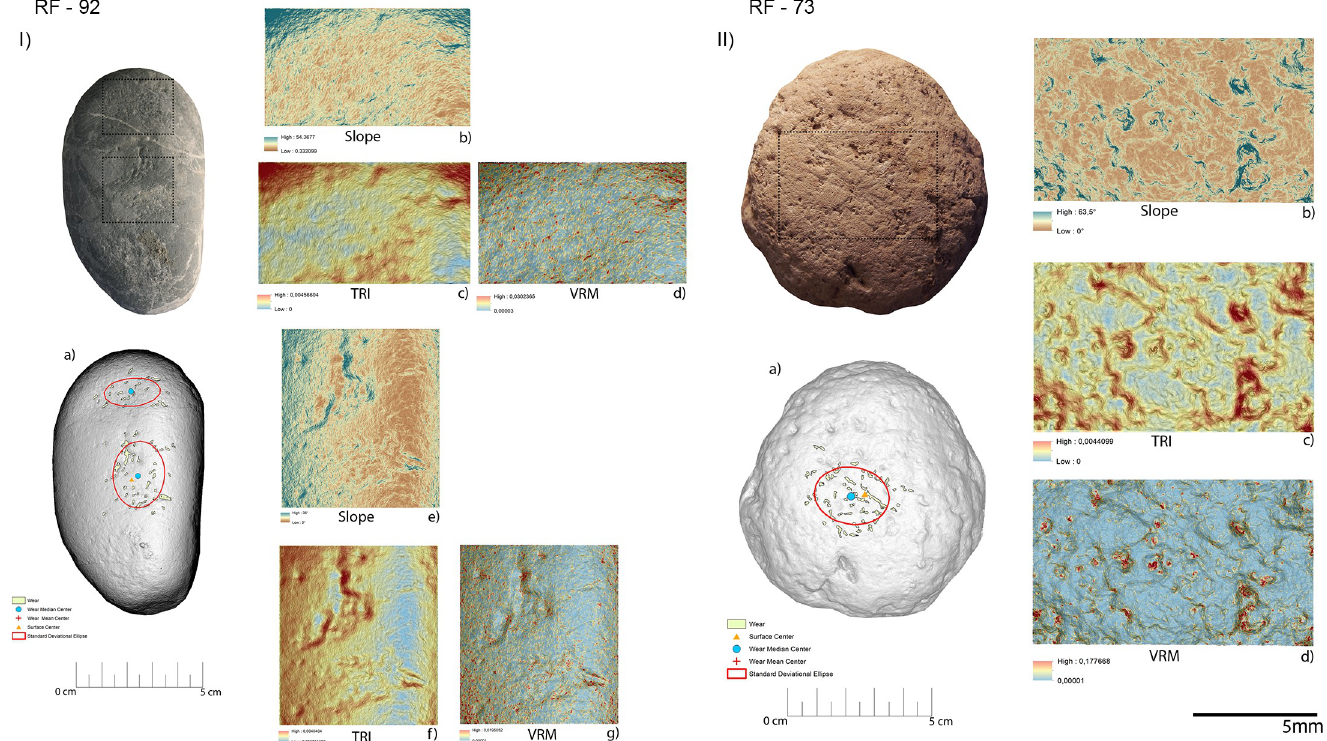
Fig 27. Archaeological items RF92 (I) and RF73 (II) utilised in retouch and percussion activities (RF92) and core ridge adjustment (RF73). (a) Spatial distribution of the identified wear; (b) slope; (c) terrain roughness index; (d) vector roughness measure.